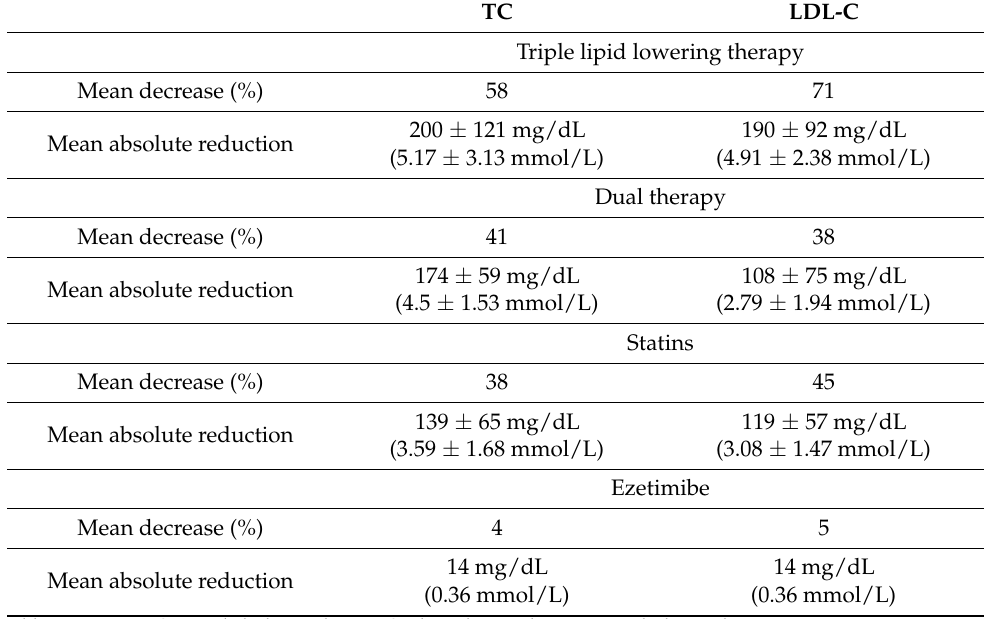
Table 4. Effectiveness of